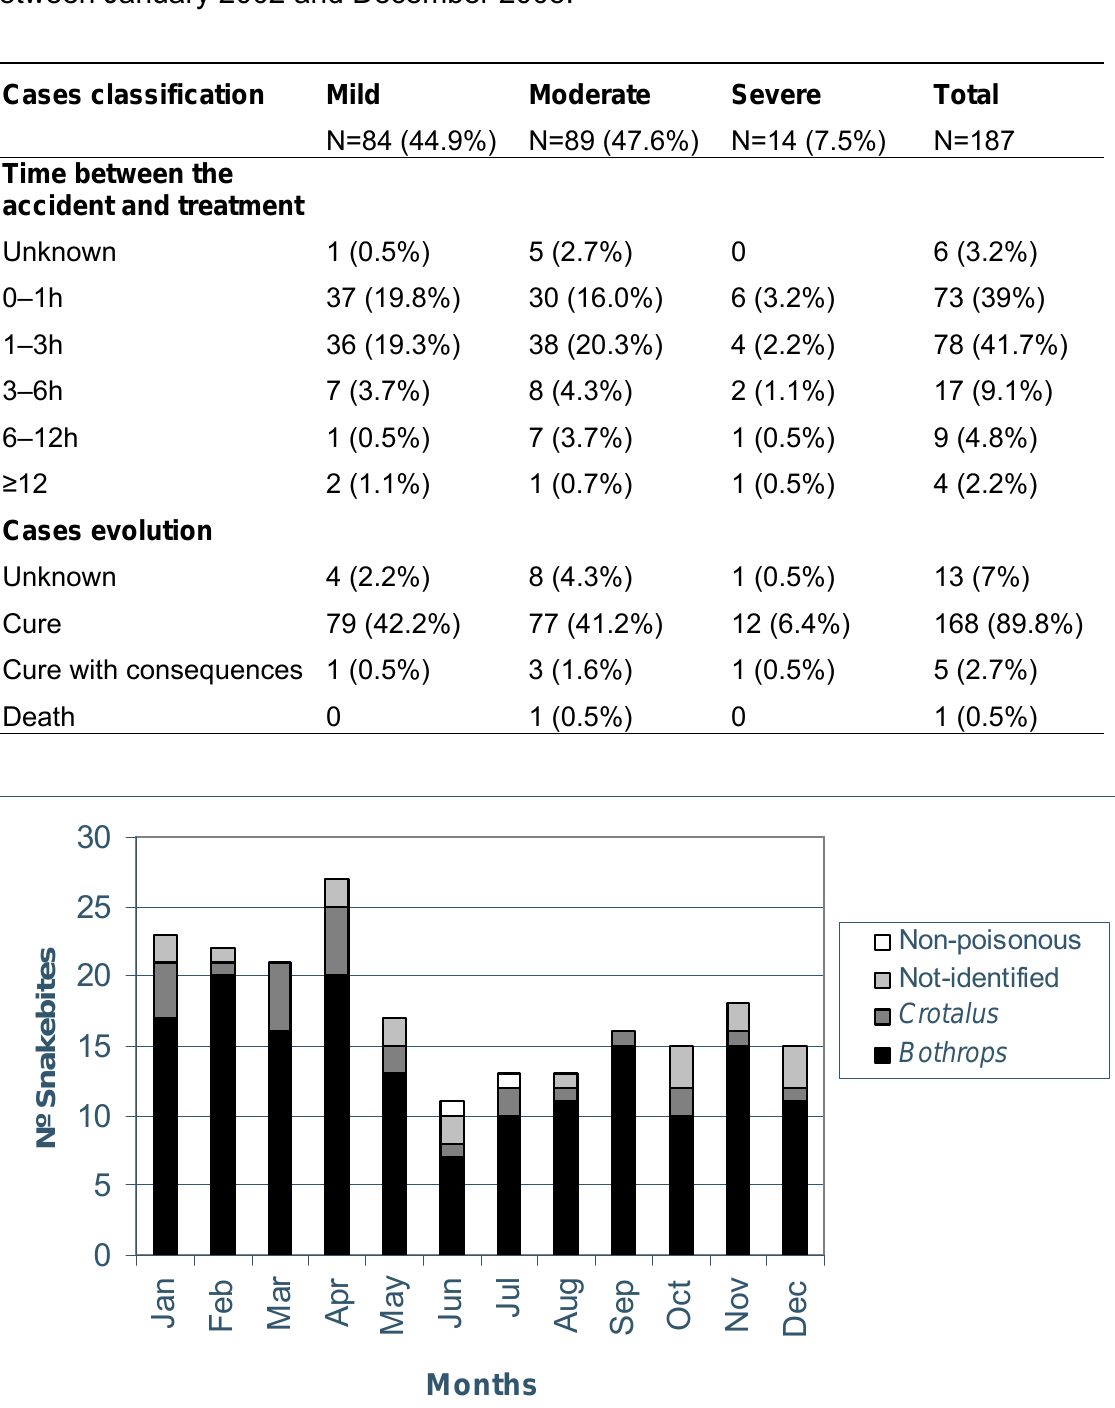
Table 3. Classification and evolution of the cases, and time elapsed between the bite and medical treatment for snakebite accidents in Southwestern Goiás State, Brazil, between January 2002 and December 2005.